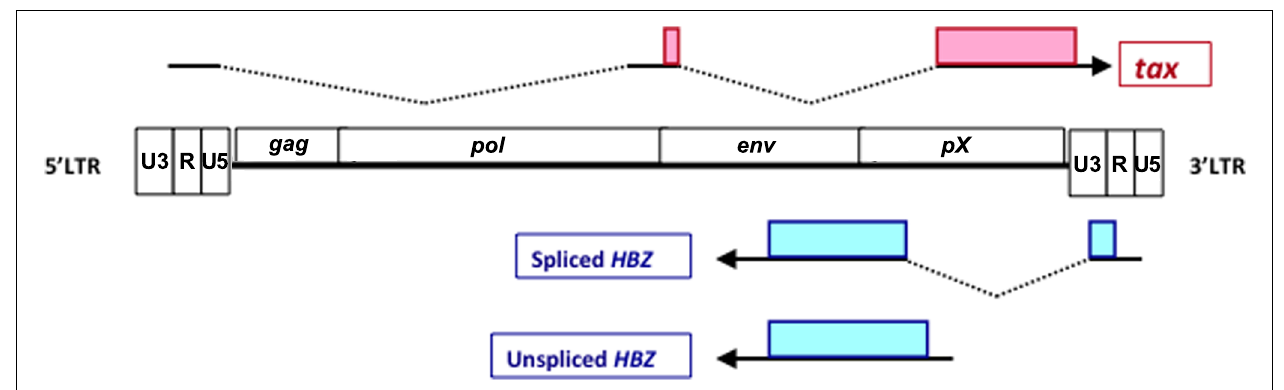
FIGURE 1 | Schematic diagram of spliced HBZ, unspliced HBZ andTax. Tax is encoded by the positive strand of HTLV-1 proviral genome. HBZ is located on the complementary strand and transcribed from 3 (cid:2) LTR. Spliced and unspliced HBZ are showed. Shaded boxes represent their coding regions.